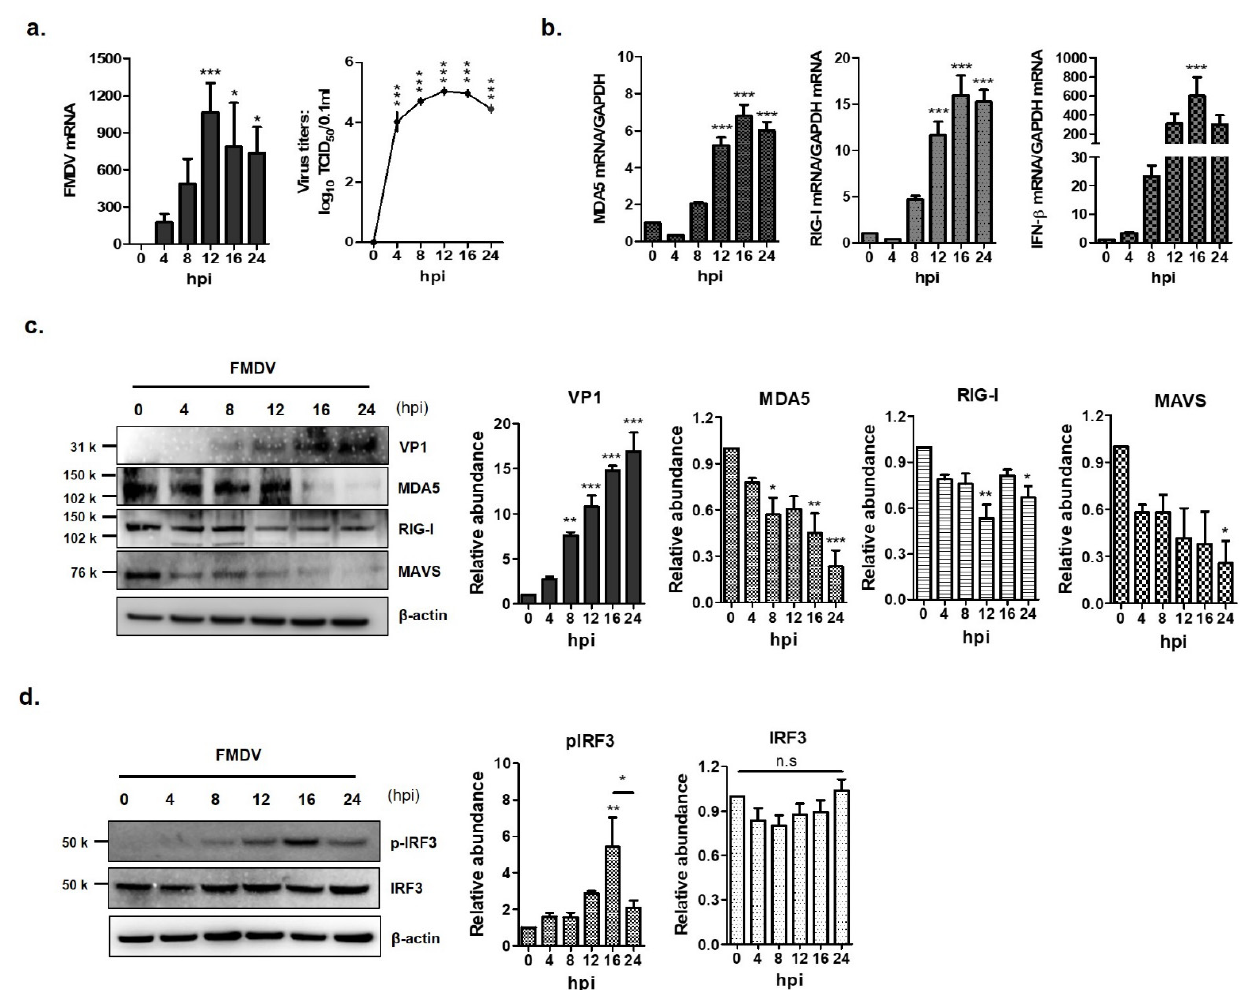
Figure 1. Down-regulation of MDA5 protein expression by foot-and-mouth disease virus (FMDV) infection. The PK-15 cells (1.5 × 10 6 cells) were infected with FMDV (0.5 MOI) and viral RNA, total RNA and protein were extracted at different times (0, 4, 8, 12 and 24 hpi) after infection. ( a ) The levels of viral RNA were examined by real-time RT-PCR (left panel) and viral titers were determined by TCID50 assay (right panel). ( b ) The levels of MDA5 (left panel), RIG-I and IFN- β (right panel) mRNA in the cell lysates were determined by real-time RT-PCR normalized to GAPDH. ( c ) The levels of endogenous MDA5, RIG-I proteins and VP1 structural protein of FMDV were detected by Western blotting. ( d ) The expression levels of the IRF3 and p-IRF3 proteins were analyzed by Western blotting (left panel). All experiments were performed in triplicate and presented as mean ± SEM (*, p < 0.05; **, p < 0.01; ***, p < 0.001 and n.s., not significant). The abundance of proteins were calculated by Image J software to quantify the band intensity, normalized to β -actin and respectively compared with the 0 hpi.